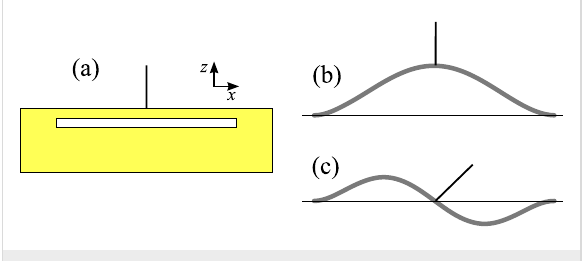
Figure 1: (a) Proposed geometry of new sensor. A tungsten tip connected to the centre of a quartz bar clamped at both ends. (b) First and (c) second eigenmode of the sensor. The symmetry provides pure normal motion in the first eigenmode and lateral motion of the tip